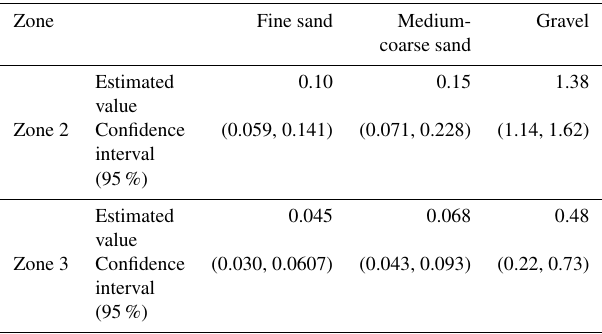
Table 4. Variances of log 10 (K) of different facies along the dip direction in zone 2 and zone